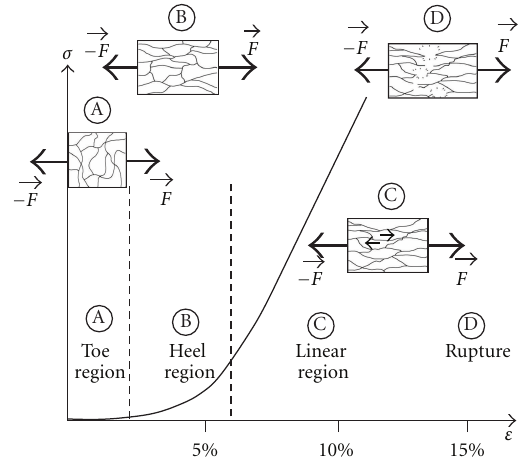
Figure 6: Proposed molecular mechanism involved during the collagen gel stretching when applying a tensile load F . Four regions can be identified: (A) “toe region” (low strains), (B) “heel region” (nonlinear region), (C) linear region (small arrows symbolize friction), and (D) rupture of the